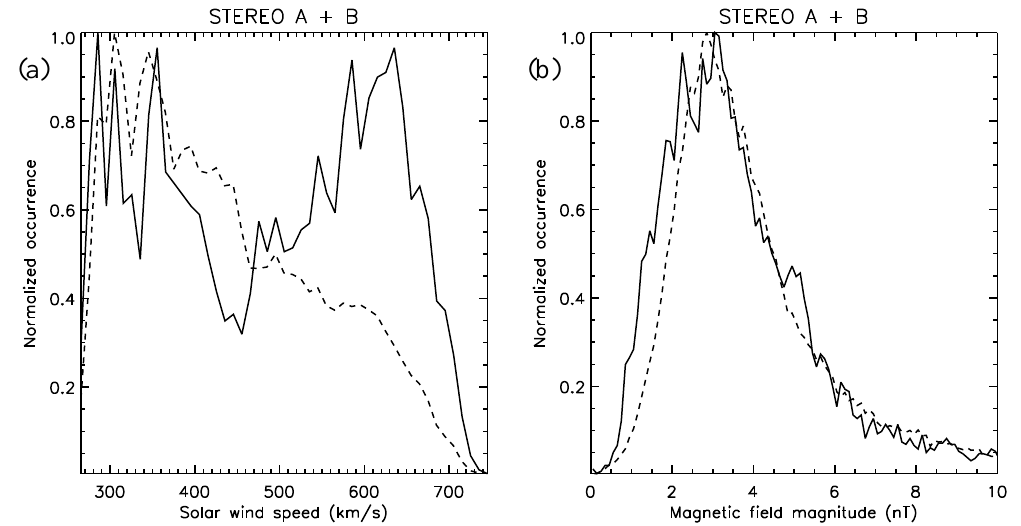
Fig. 5. Normalized occurrence distributions of (a) bulk solar wind speed, and (b) magnetic field magnitude, for data from ST-A and ST-B combined. The dashed lines show the distributions for the whole dataset used in the study, while the solid lines show the distribution for times of counter-streaming suprathermal electrons (CSE). The distributions are for a depletion value threshold of 0.8. Those for other depletion values are similar (not shown).